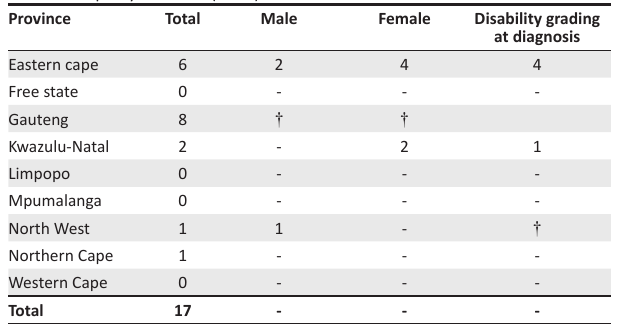
FIGURE 2: Male patient with lepromateous leprosy, presenting with madarosis (loss of eyebrows), thickened dry skin, nasal congestion and auto-amputation of the little finger on the right hand.